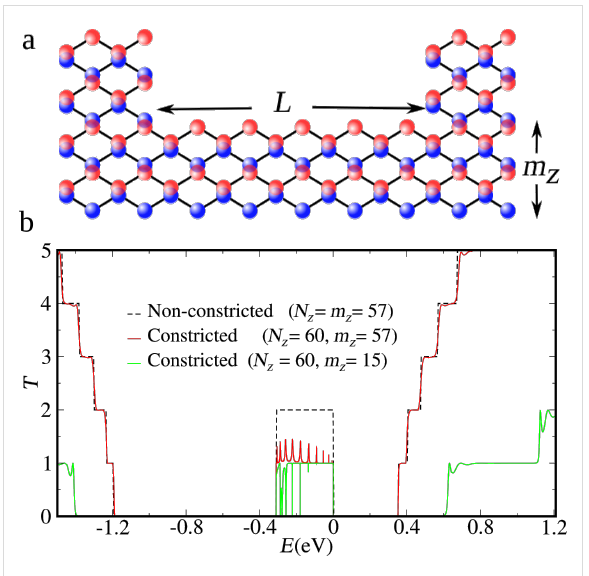
Figure 2: (a) Schematic picture of a constriction characterized by the parameters L = 10, actually used throughout the work, and m z = 4, here only for the sake of illustration. (b) Transmission probabilities, as a function of the Fermi energy, at the energy range corresponding to the central band, including the bottom and top of the conduction and valence bands. Three different situations are depicted: two constric- tion defined at nanoribbons of width N z = 60, both with L = 10, and m z = 57 (red) and m z = 15 (green) and a zigzag nanoribbon without any constriction, N z = m z = 57 (black